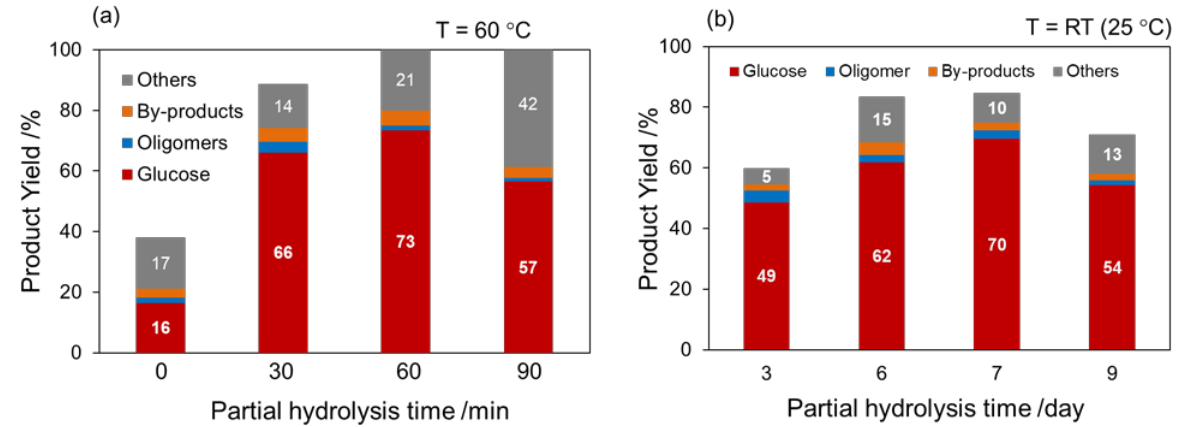
Figure 6. Product yield after hydrolysis of cellulose dissolved in H 3 PO 4 and hydrolyzed partially for various times at ( a ) 60 ◦ C and ( b ) room temperature before adsorption on AC-Air. Reaction conditions: Wet cellulose + AC-Air mixture, 40 mL water, 180 ◦ C, 20 min. By-products include fructose, 5-HMF and levoglucosan. “Others” is the difference between cellulose conversion and identifiable